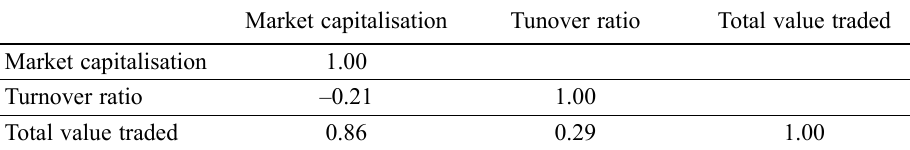
Table 2B. Correlation matrix of stock market development indicators